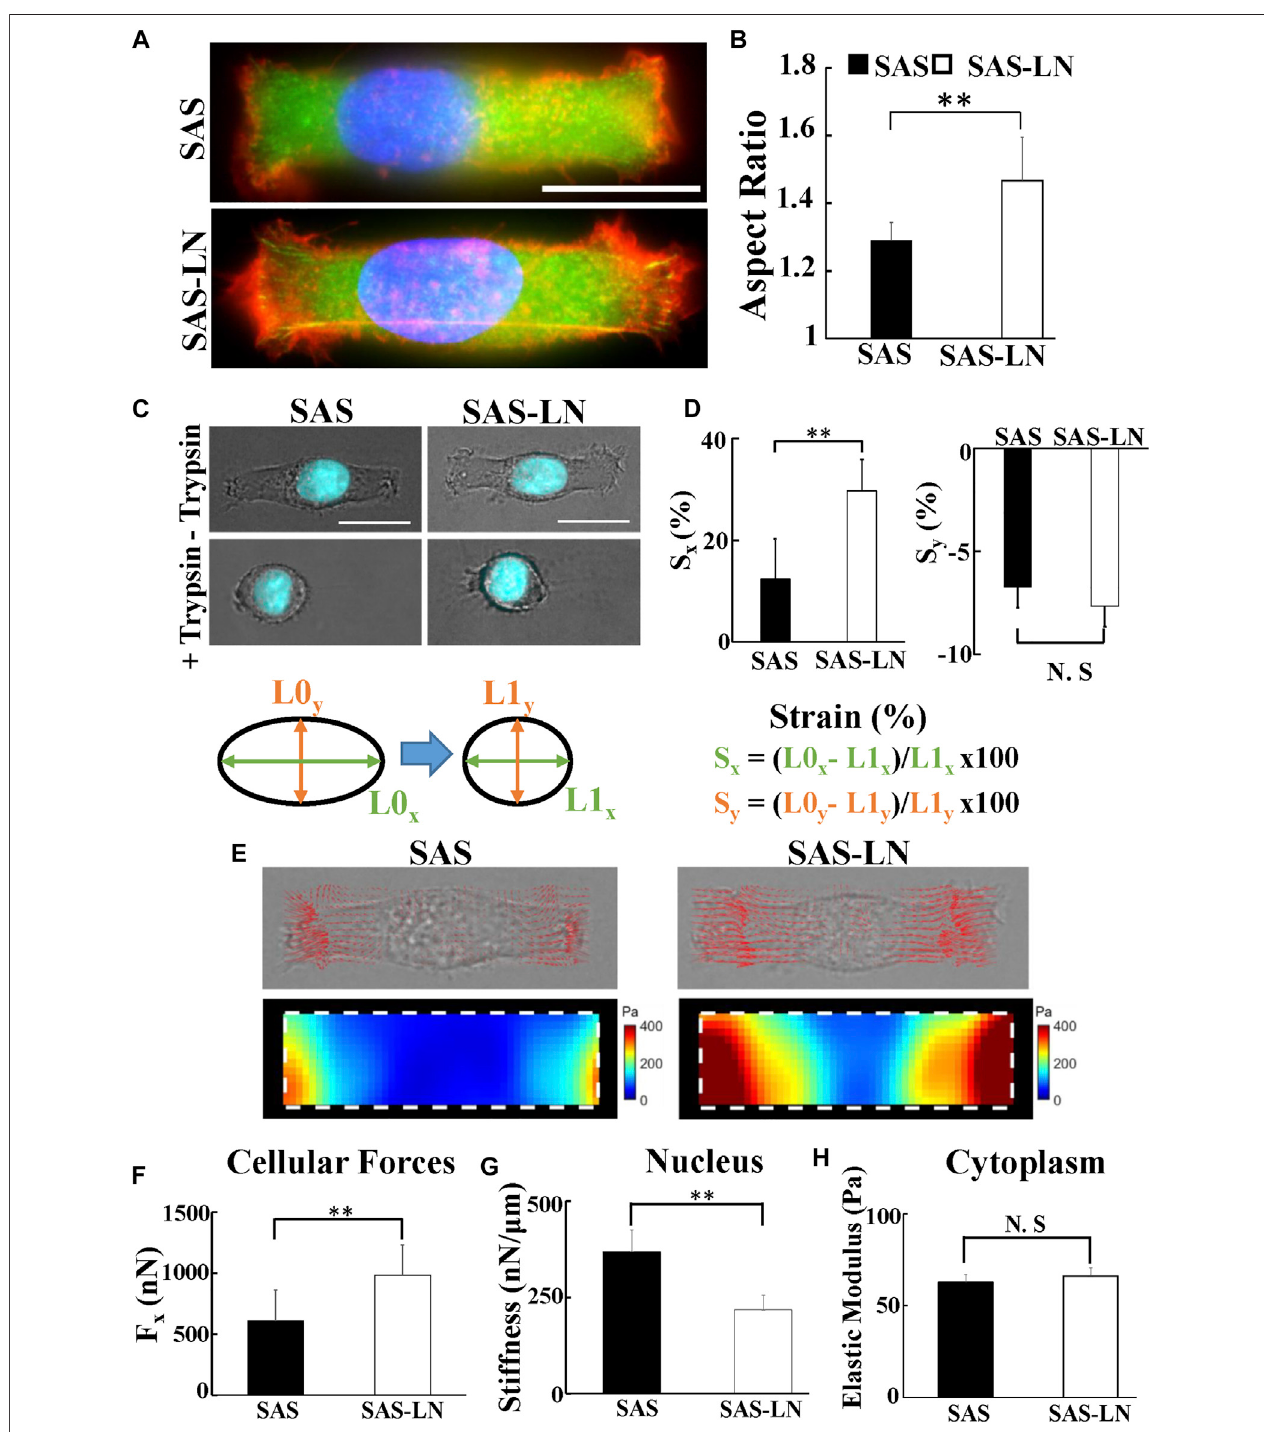
FIGURE 3 | The biomechanical properties of LN-metastatic HNSCC cells (SAS-LN) and non-metastatic HNSCC cells (SAS). (A) Representative immuno fl uorescenceimagesofSAS-LNandSAScellsculturedontherectangularmicropatterns.Blue:nucleus(Hoechst33342),red:TRITC-labeledphalloidinforactin, andgreen:FITC-labeledpaxillin. (B) AnalysisofthenuclearmorphologyofSAS-LNandSAScells,culturedontherectangularmicropatterns(length=55 μ mandwidth= 18 μ m). Data represent mean ± SD (n = 20). *, for p < 0.05 and **, for p < 0.01; N.S: not signi fi cant. (C) Phase contrast and fl uorescent images of nuclear morphologyofSAS-LNcellsandSAScells,culturedontherectangularmicropatterns,before(upperpanels)andafter(lowerpanels)trypsintreatment.Blue:cellnucleus. Scale bars=20 μ m. (D) Analysis of the longitudinal (S x ) and transverse (S y ) strain of nuclei, along the major axis and the minor axis of the rectangular micropatterns,